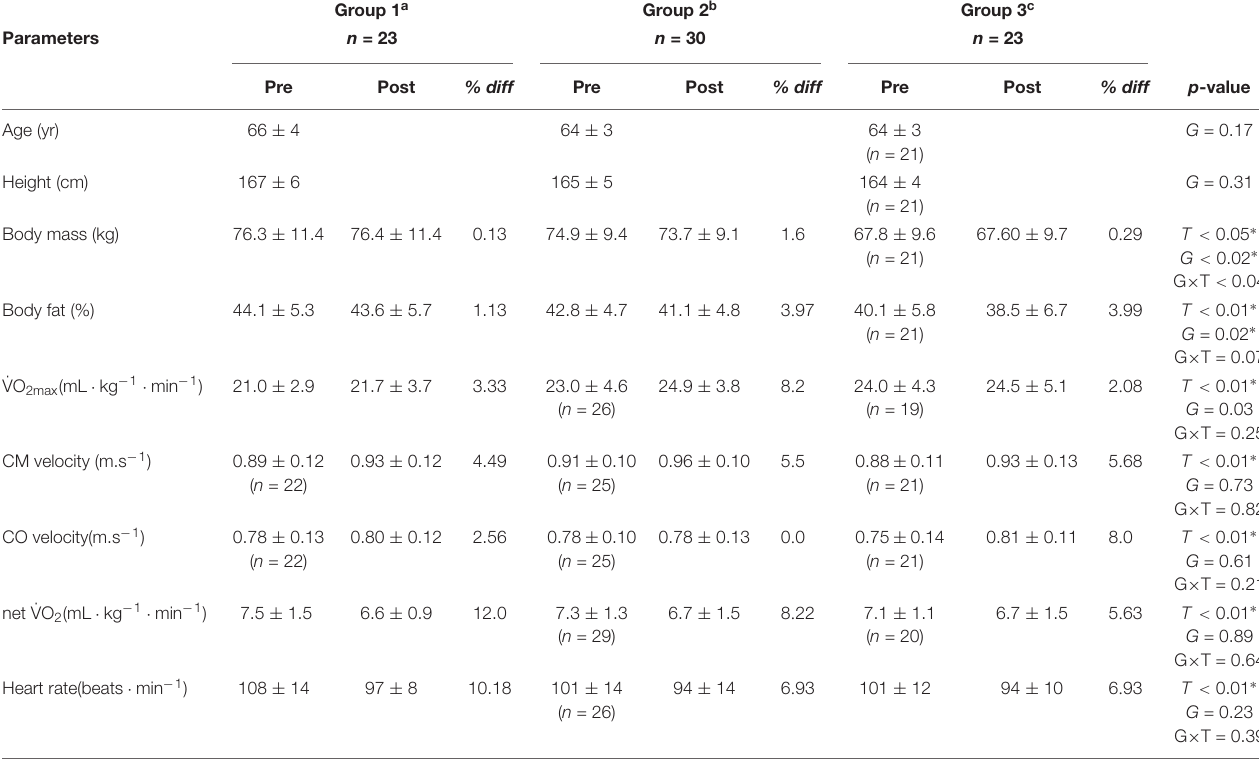
TABLE 2 | Differences in physiological and functional parameters for each respective groups.